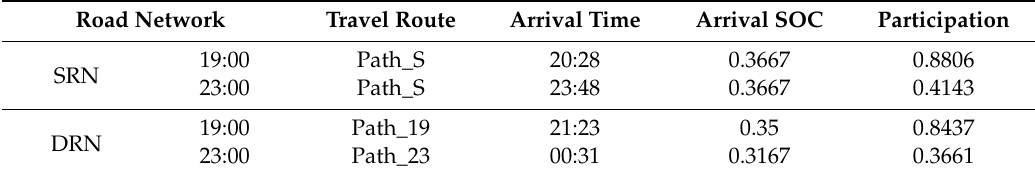
Table 9. Participation Simulation Results in Di ff erent Road Networks.